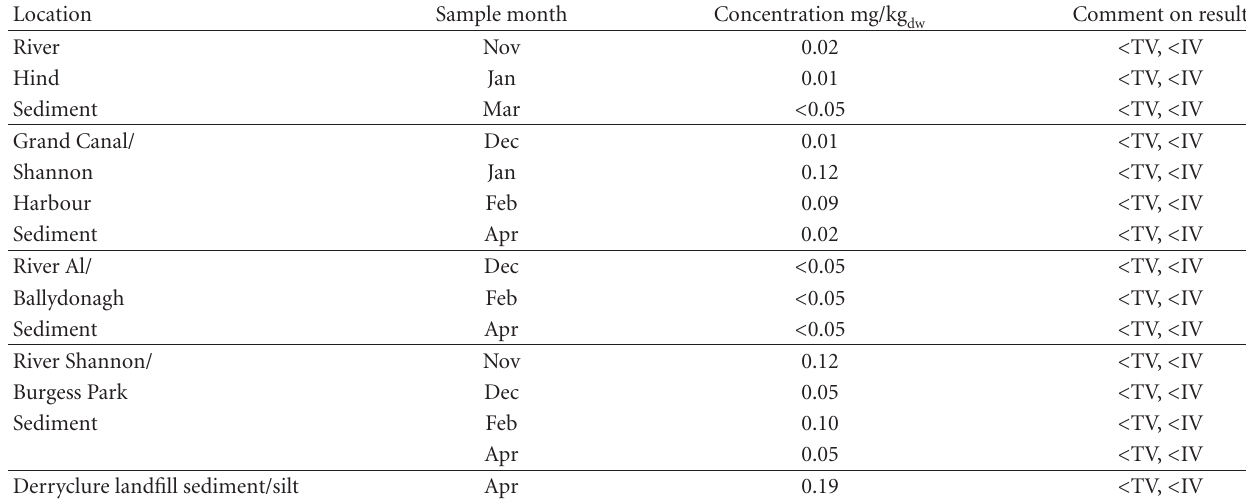
Table 5: Mercury concentrations in river sediments and leachate sediments, 2004-2005.